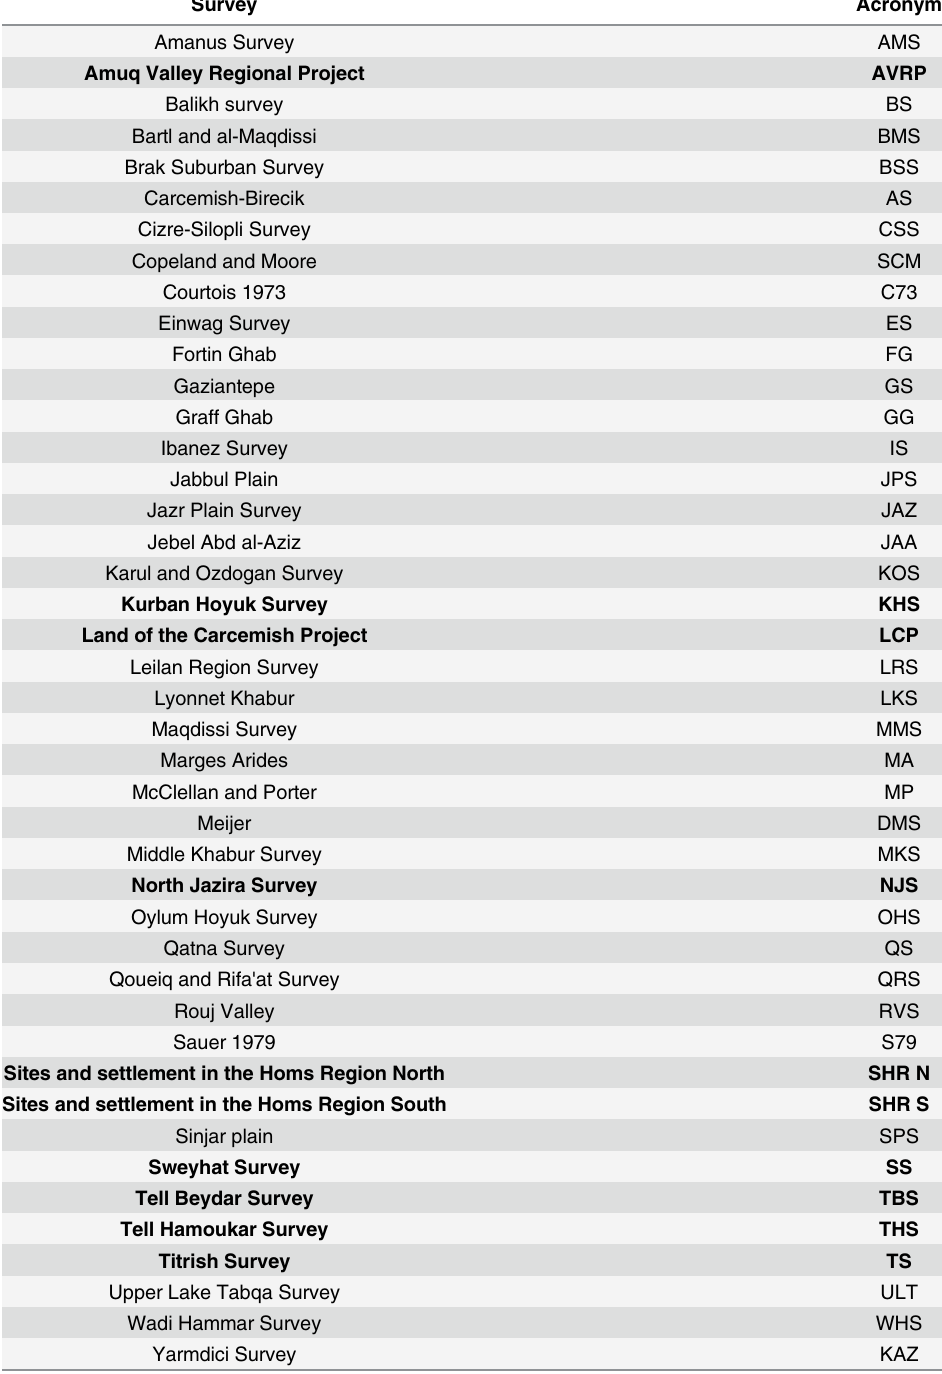
Table 1. Surveys used in this paper. Surveys in bold provide sample site areas and densities, other sur- veys provide information for the urban dataset. See S1 Appendix Sheet 1 for details.